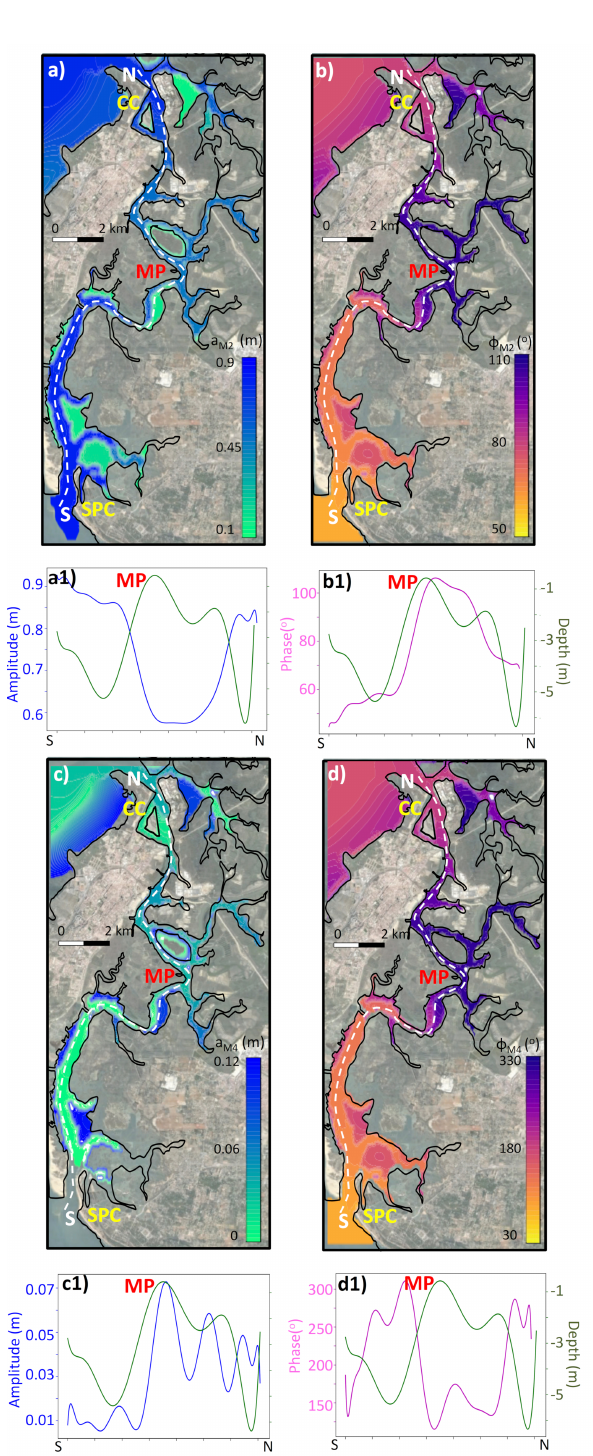
Figure 6. Results of the tidal harmonic analysis. Panels a and b show a color-coded representation of the modelled amplitude ( a ) and phase ( b ) fields for the M2 component, whereas panels ( c , d ) portray the same fields for the M4 component. The panels ( a1 – d1 ) show tidal amplitudes and phases for the flood and ebb phase along the path represented by the with dashed lines in panels ( a – d ). For the sake of clarity water depths along the white dashed path are also shown in green in the same